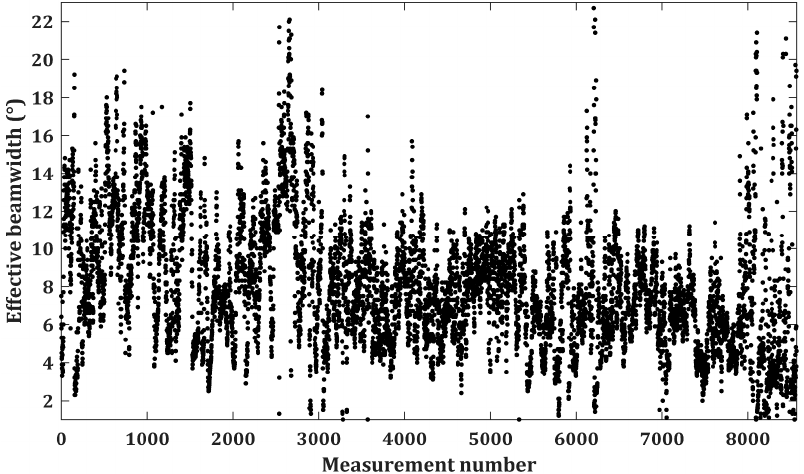
Figure 11. The results of effective beamwidth for 8565 Tomoradar measurements. The dots denote the locations of effective beamwidth for each measurement.